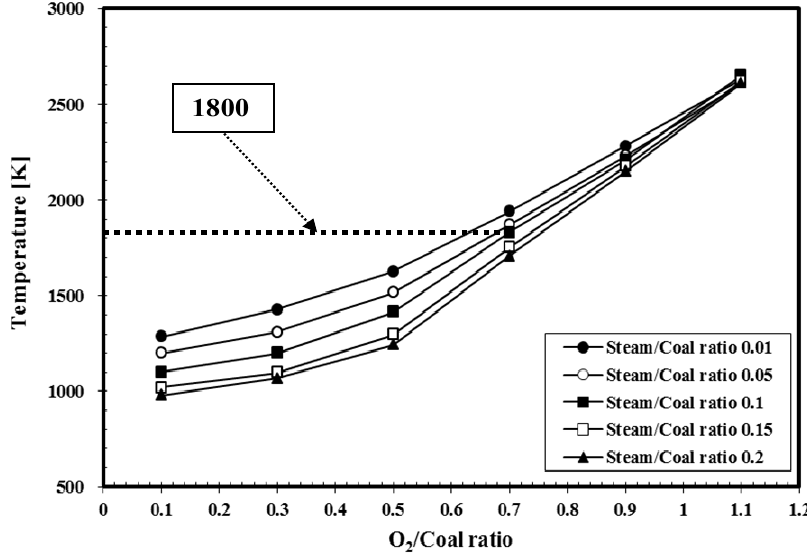
Figure 7. Temperature at outlet with respect to O2/coal and steam/coal